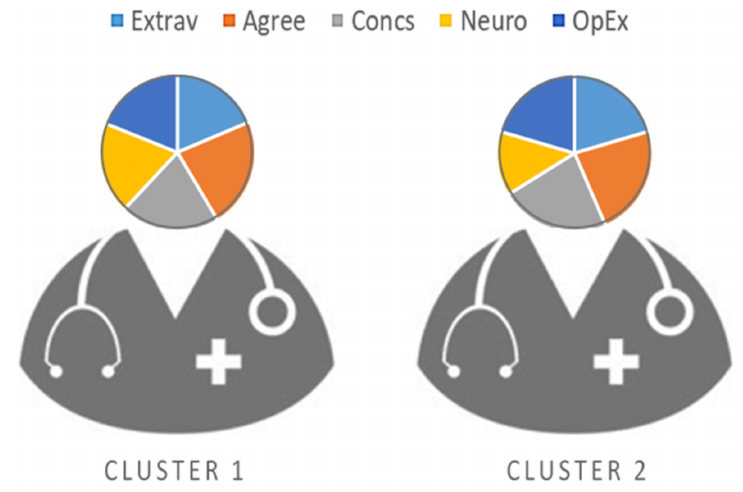
Figure 1. Personality factor